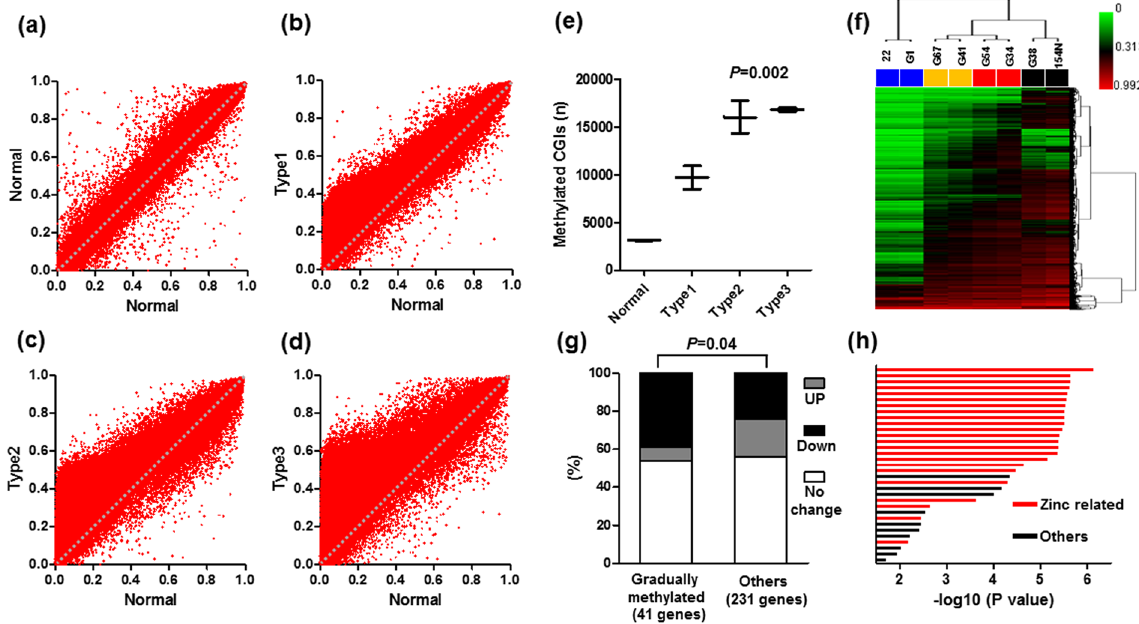
Figure 4. Genome-wide methylation analysis in CpG islands (CGIs). ( a – d ) The development of mucosal patterns from normal to types 1, 2, and 3, and methylation accumulation in CGIs. ( e ) Mean number of methylated CGIs from normal to types 1, 2, and 3. Statistical analysis was performed using one-way ANOVA. ( f ) Unsupervised hierarchical clustering analysis of 10% of the most variant probes. Blue, yellow, red and black boxes represent normal and type 1, 2, and 3 samples, respectively. Sample ID numbers are listed above the boxes. ( g ) Gene expression fold change between normal to type 3 among genes codified by the gradually methylated PCGIs with the development of mucosal patterns from normal to types 1, 2, and 3 (41 genes) and others (231 genes). UP, upregulated > two fold; Down, downregulated > two fold; Statistical analysis was performed using chi square test. ( h ) Gene ontology analysis of genes codified by PCGIs that were gradually methylated with the development of mucosal patterns from normal to types 1, 2, and 3. The red bars represent significant enrichment of Zinc-related pathways. The black bar represents significant enrichment for other